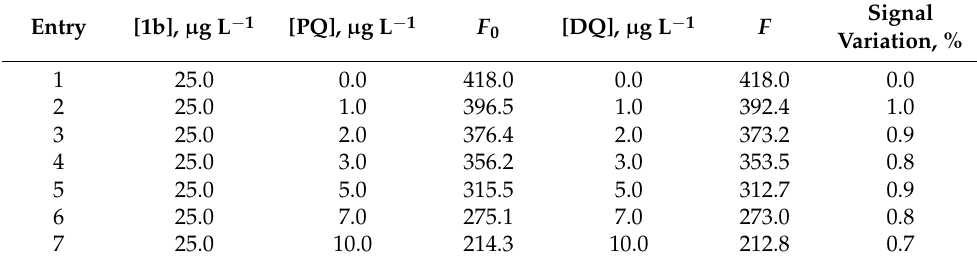
Table 11. Experimental data for the selectivity evaluation of the PQ-1b probe in the presence of diquat as interferent. The signal variation was calculated in the linear range from 1.0 to 10.0 µ g L − 1 according to Equation (6), comparing F 0 , the maximum fluorescence intensity of a paraquat solution, with F , the maximum fluorescence intensity of an equimolar solution of paraquat and diquat. The fluorescence values were measured at 416 nm for anthracene fluorophore 1b.